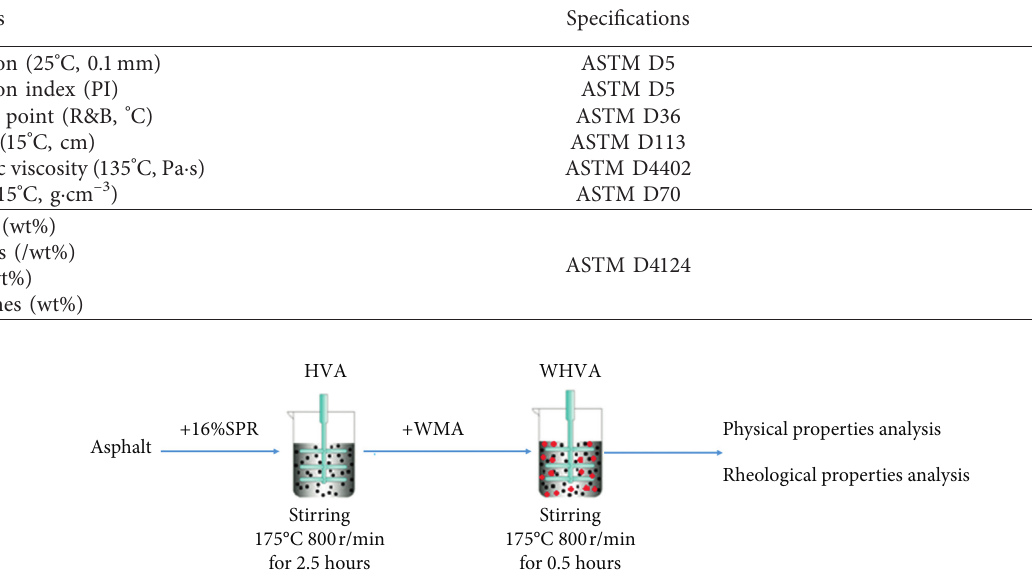
Figure 1: Preparation process of warm-mix